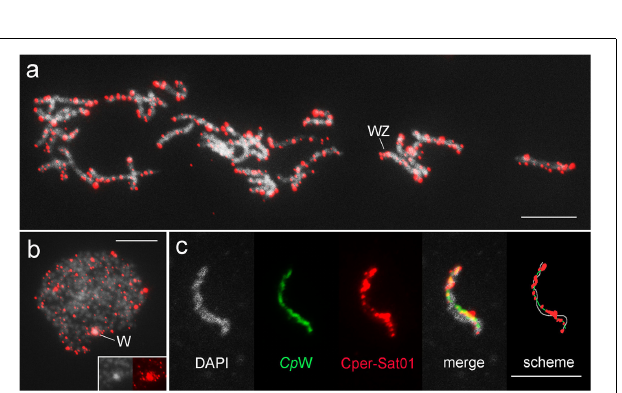
FIGURE 5 | Chromosomal mapping of Cper-Sat01 in pachytene oocyte bivalents (a,c) and interphase nucleus (b) of Cydalima perspectalis . In panel (c) , a detail of the WZ bivalent with the W chromosome identified by the W-painting probe (green) is shown, which allows accurate mapping of the distribution of Cper-Sat01 clusters (red). Note the enrichment of the clusters on the W chromosome relative to the Z chromosome. In panel (b) , note the strong hybridization signals concentrated on the W chromatin body; the inset shows a detail of the W chromatin body stained with DAPI (gray on the left) and with the probe (red on the right). Bar = 10 µ m.